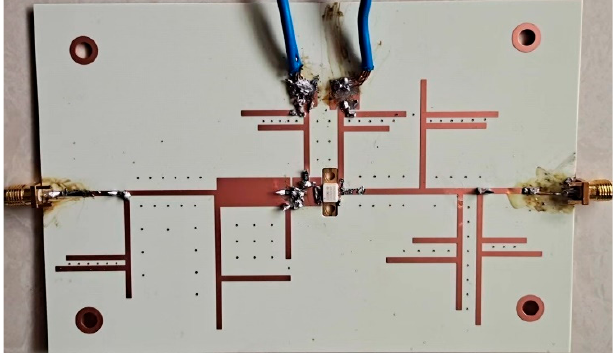
Figure 10. Picture of power amplifier PCB board.